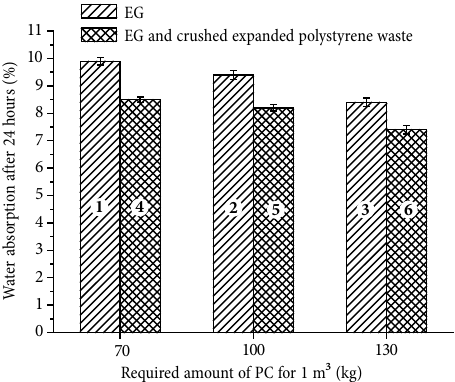
Fig. 7. Influence of the amount of PC on water absorption of LWAC samples of 1÷6 compositions